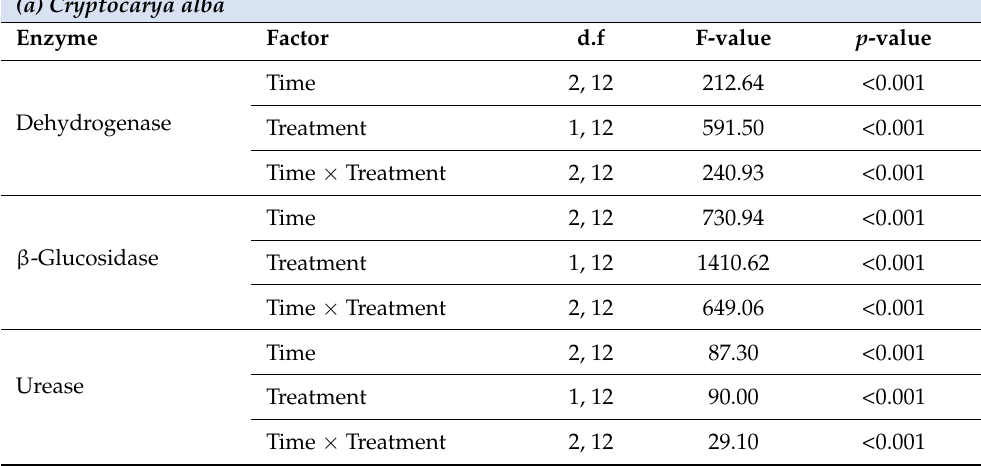
Table 3. Results of two-way repeated measur es ANOVA on enzymes for the four tree species. Main factors: Time, AMF treatments, and their interaction. Degrees of freedom (d.f.), F - values, and p - val- ues are shown.